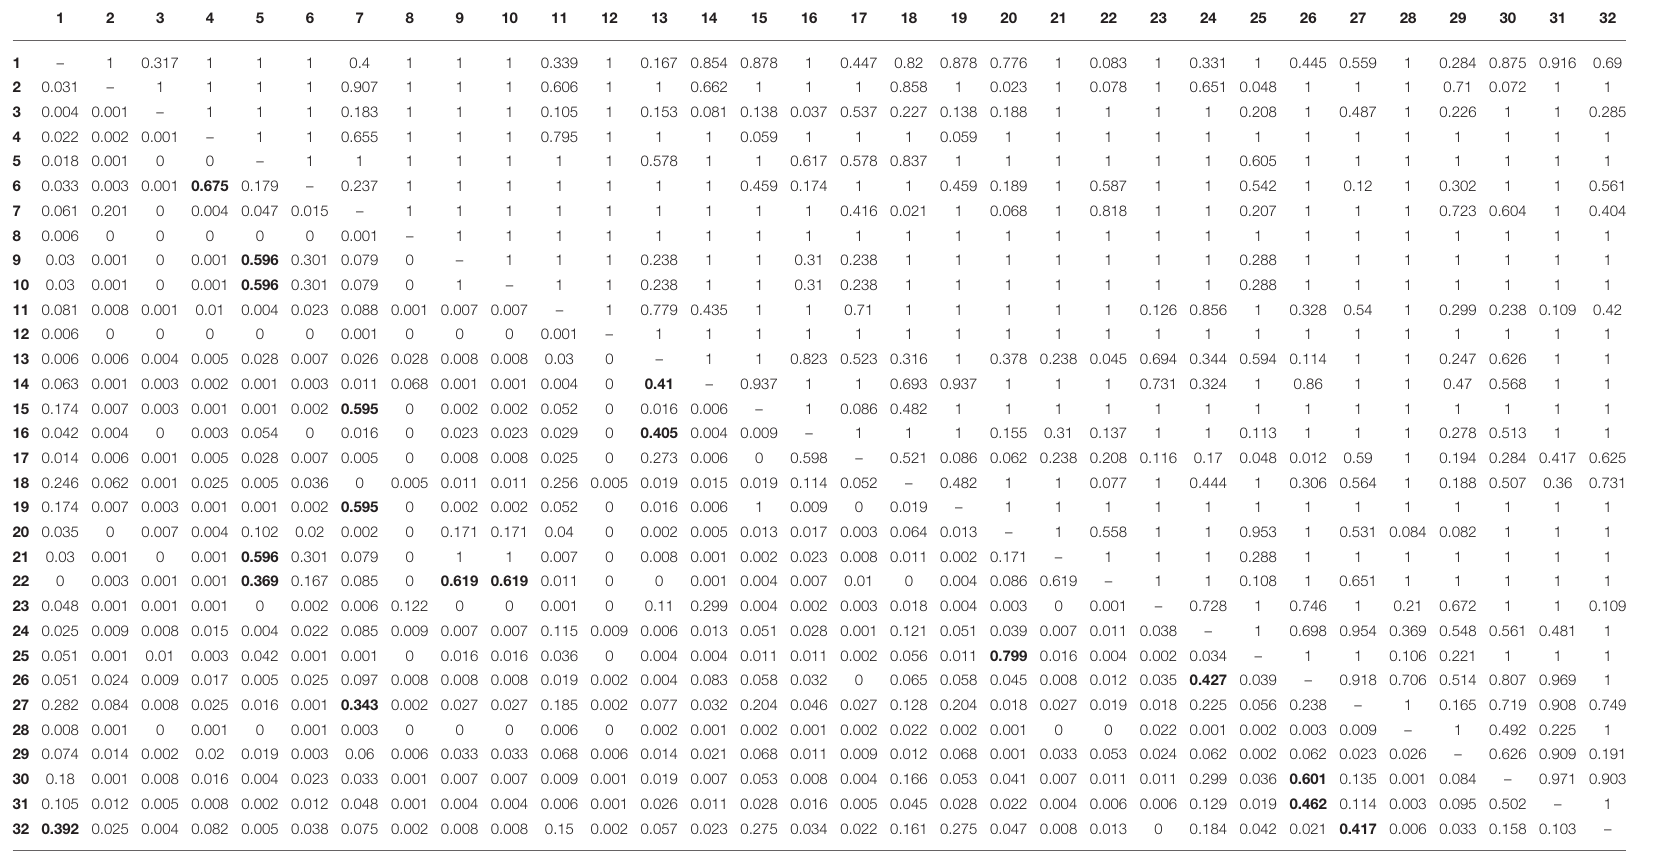
TABLE 2 | Linkage disequilibrium (LD) among genetic polymorphisms of the pheasant PRNP gene in